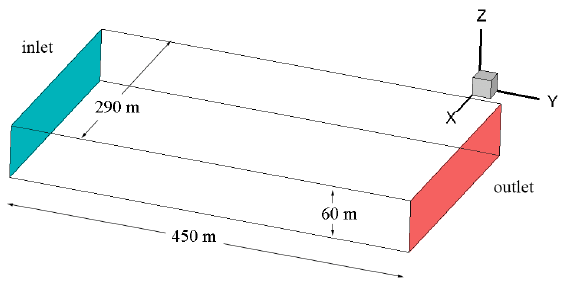
Figure 2. Simulation domain with inflow side (green), and outflow side (red).